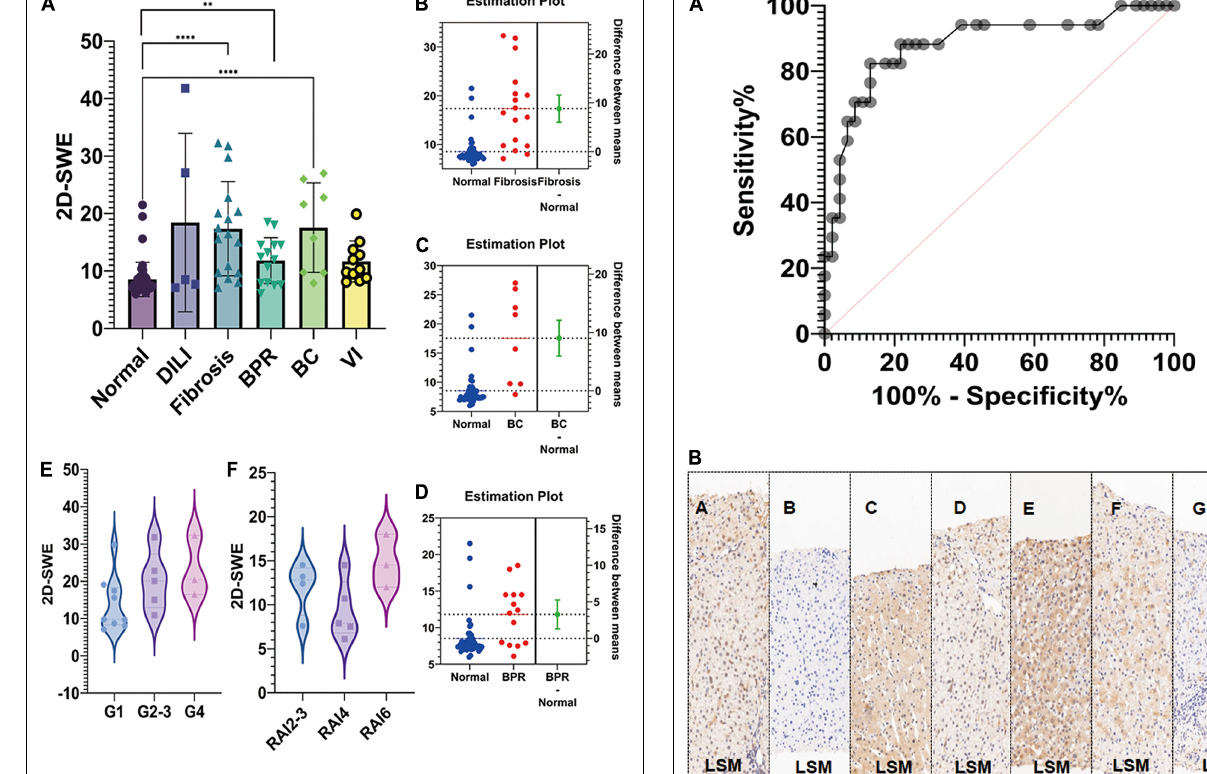
FIGURE 2 | The liver stiffness measurement (LSM) and pathological findings of post-transplant pediatric liver biopsy. (A) . The LSM value of two-dimensional shear wave elastography (2D-SWE) was shown in the bar figure. 2D-SWE LSM value significantly elevated in post-transplant fibrosis, biliary complication, and biopsy-proven rejection (BPR). (B) . The difference between means of 2D-SWE LSM value was 8.824 ± 1.397 kPa IN FIBROSIS-NORMAL. The LSM value of patients with post-transplant biliary complication and biopsy-proven rejection also rose compared to normal recovery patients, with the difference between means at 9.025 ± 1.530 kPa (C) and 3.283 ± 0.9918 kPa (D) , respectively. (E) . The LSM ascended when the grade of fibrosis grew, despite no significant difference among each group ( p = 0.166). This trend was not detected in acute rejection (F) ( ∗∗∗∗ p < 0.0001; ∗∗ p < 0.01).